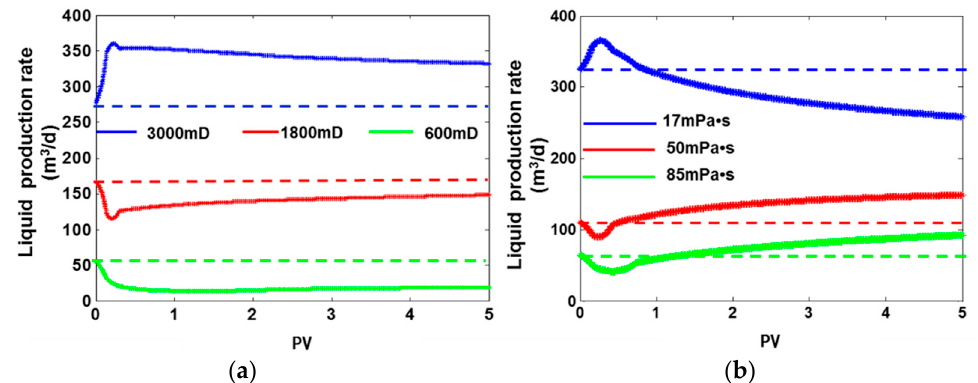
Figure 8. Comparison of the liquid production rate with a permeability-to-viscosity ratio ranging from 0 to 5 PV. ( a ) Permeability ratio = 5; ( b ) Viscosity ratio = 5.